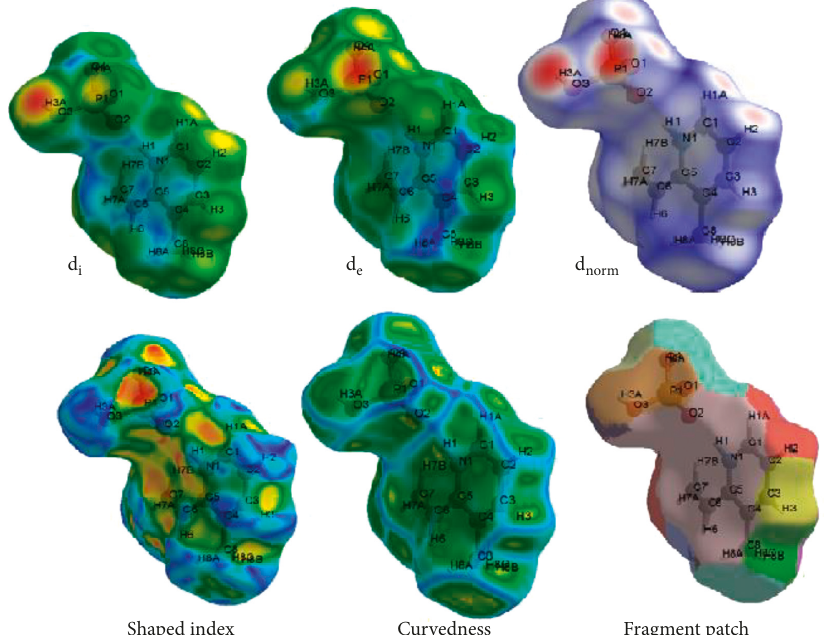
Figure 8: Hirshfeld surface analysis d i , d e , d norm , shape index, and curvedness of 3M2VPP.